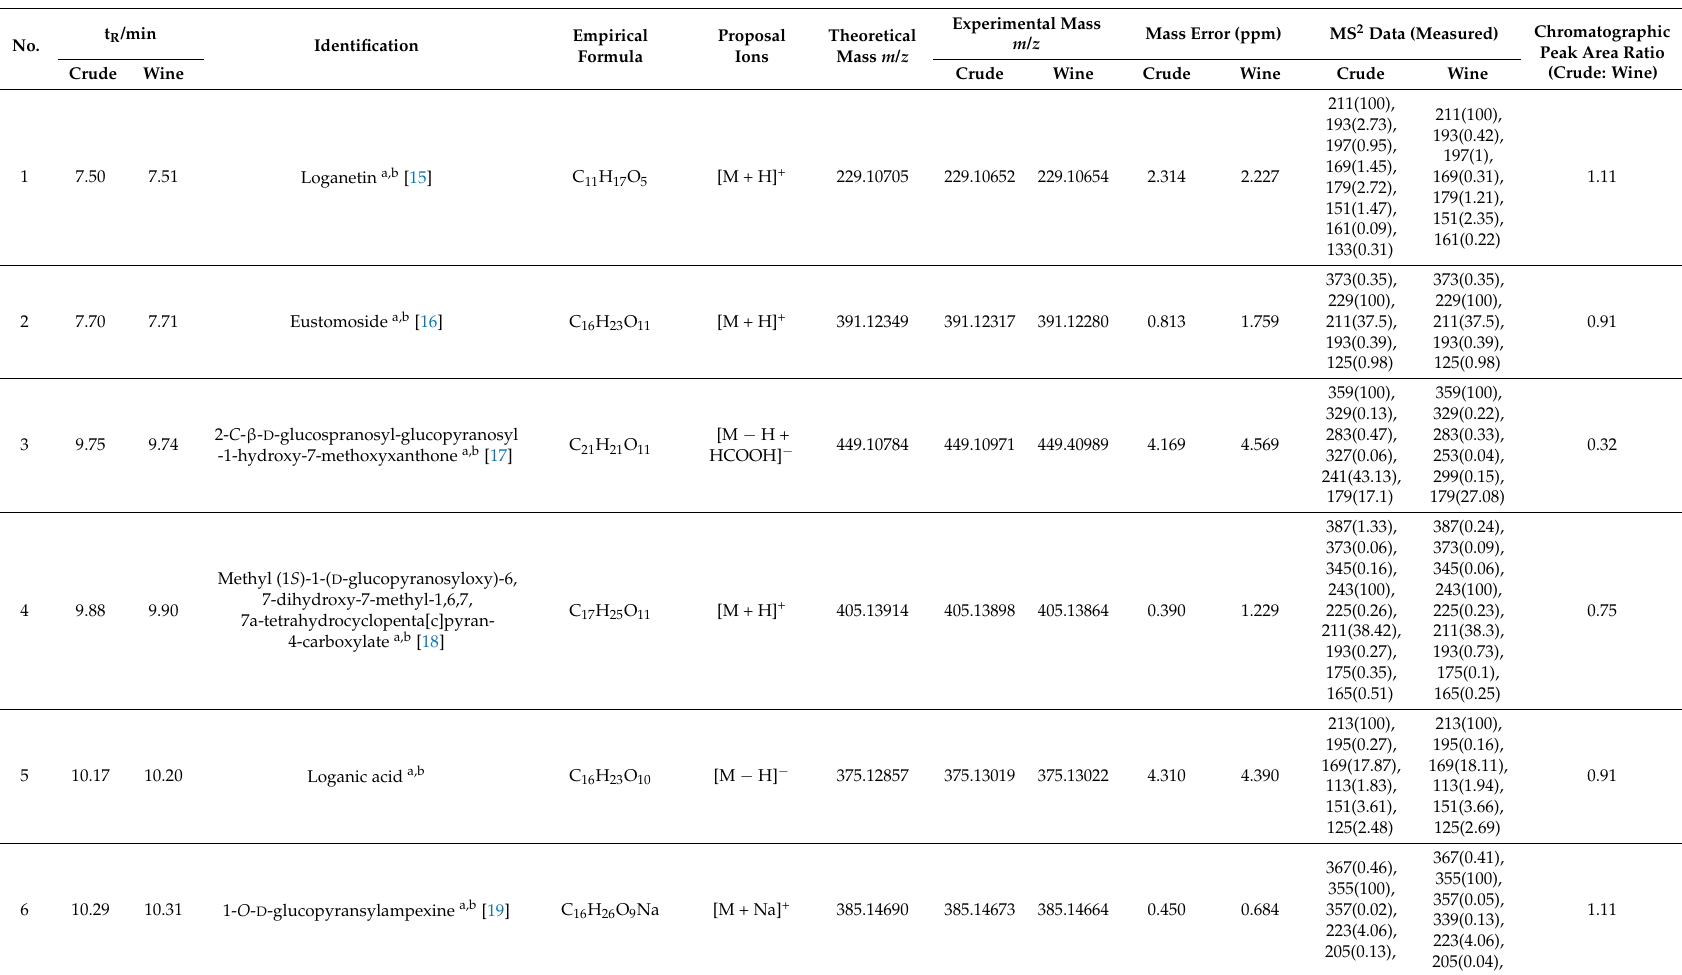
Table 1. Identification of chemical constituents of crude and wine-processed Gentiana radix by UHPLC-LTQ-Orbitrap.